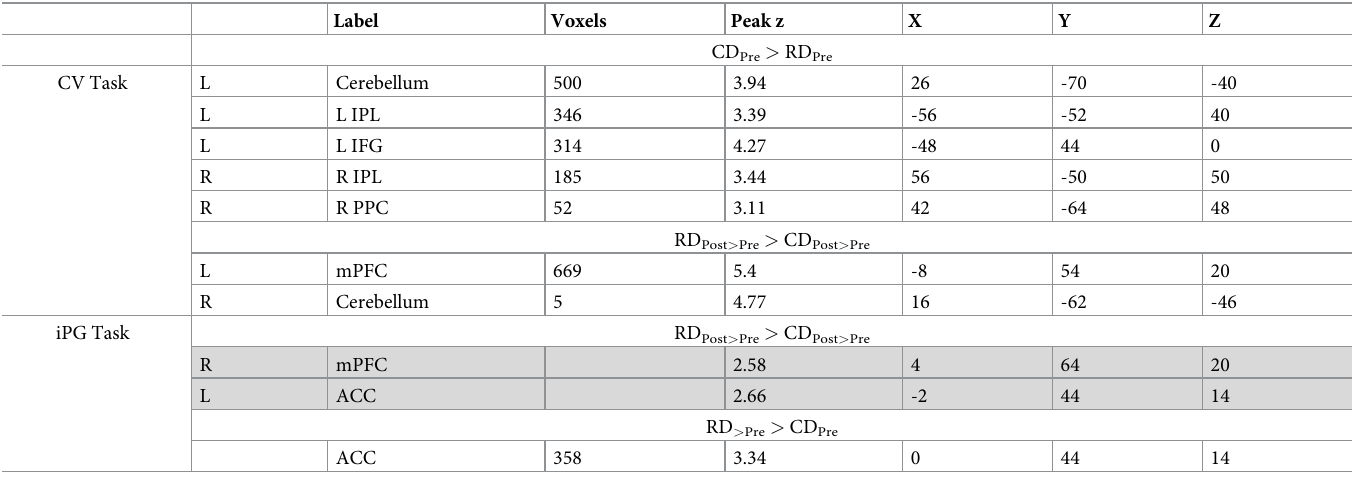
Greyed rows indicate a cluster expressing the Group-by-Session effect only at an uncorrected (p < .01) level.